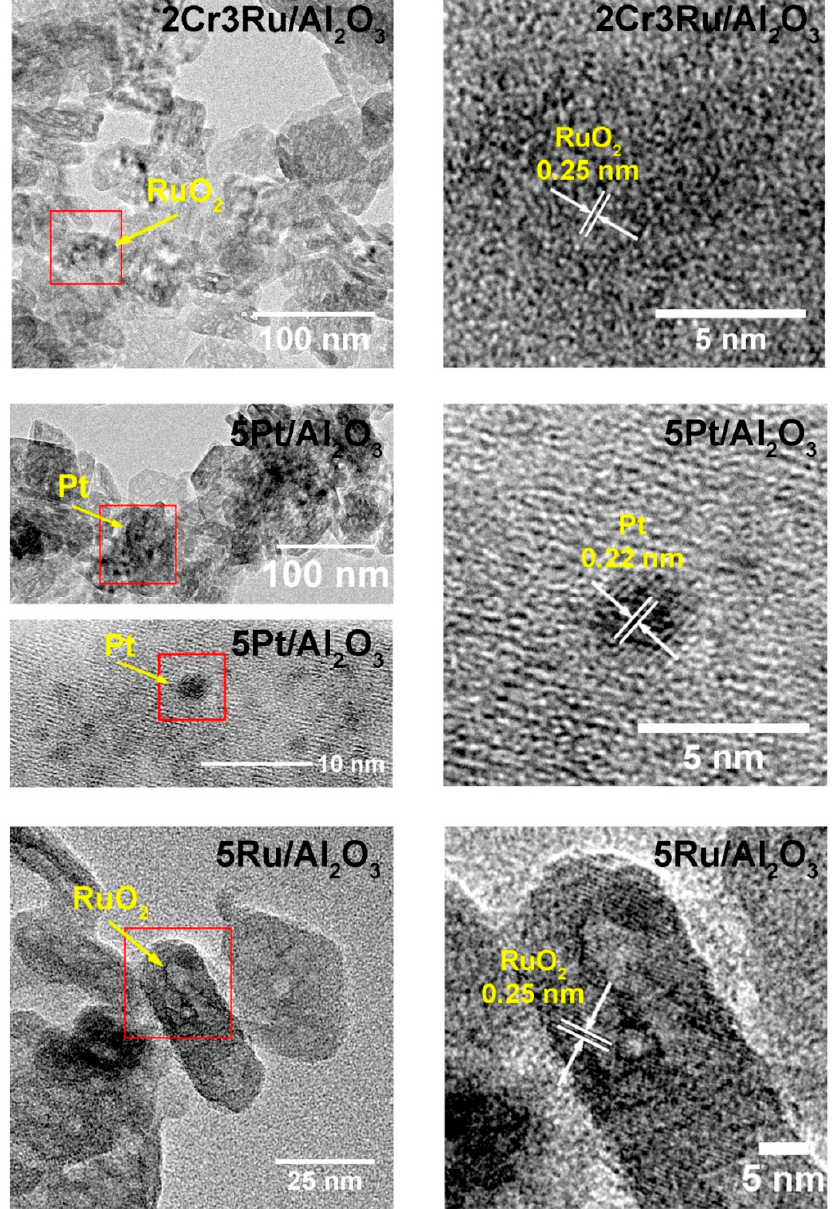
Figure 6. HR-TEM images of fresh 5Pt, 5Ru, 5Cr, and 2Cr3Ru supported on Al 2 O 3 .